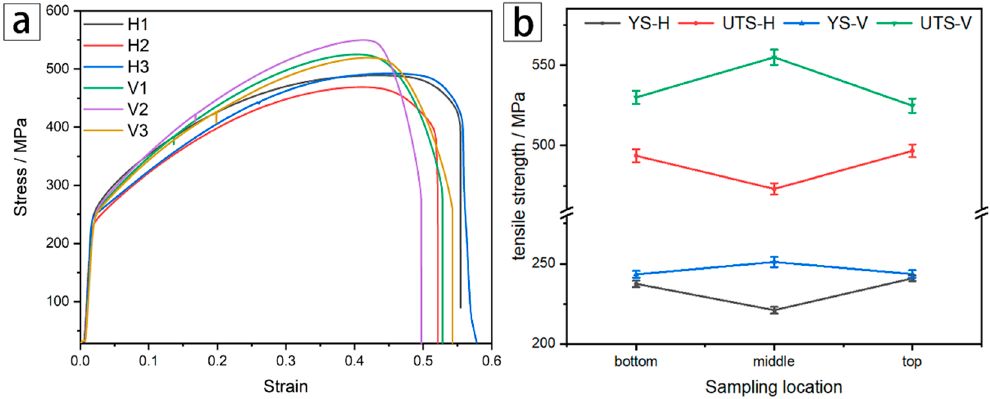
Figure 11. Tensile test results of each sample: ( a ) Stress–strain curves of horizontal and vertical tensile specimens, and ( b ) variation in the tensile strength of horizontal and vertical tensile specimens.